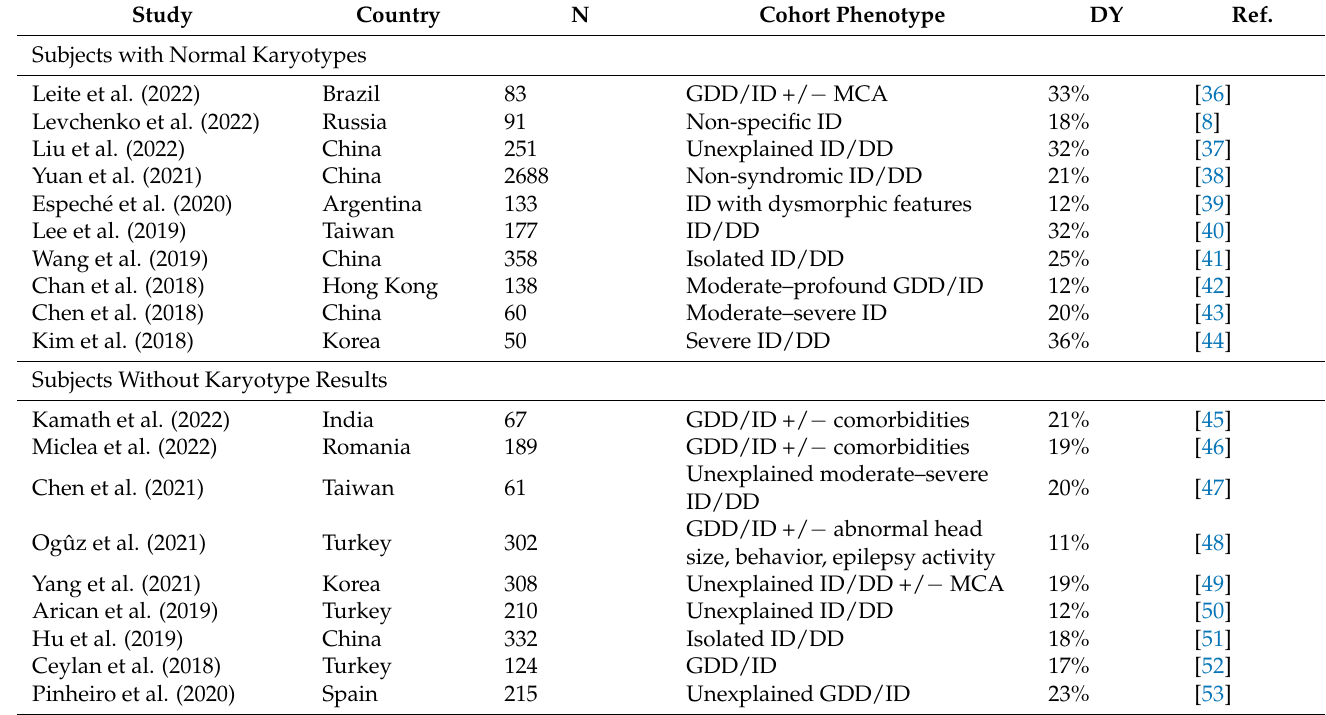
Table 3. Chromosomal microarray analysis of individuals with intellectual disabilities/developmental disabilities in recent